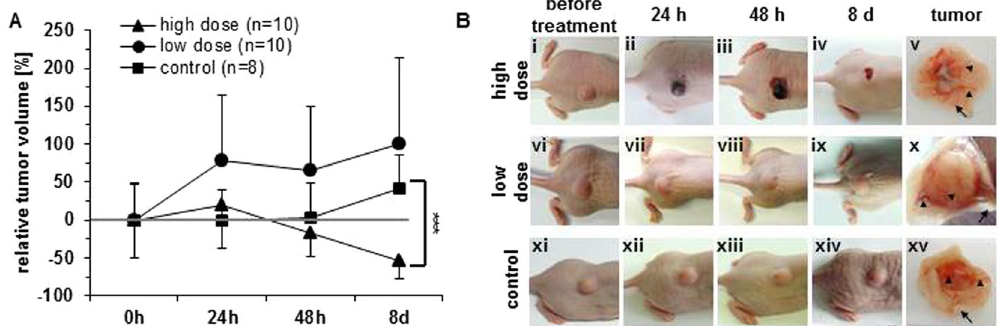
Figure 6. Low dose hyperthermia (42 °C) has no distinct impact on tumor volumes, whereas high dose hyperthermia (46 °C) induces tumor regression. ( A ) Tumor volumes after hyperthermia were normalized to the initial value prior to treatments. Data represented as mean ± SD (n = 8 or 10 mice for each condition). ( B ) Light images of tumor-bearing mice. The last panel on the right side represents dissected tumors with high degree of vascularization upon application of high dose hyperthermia (arrow-heads = tumor vasculature, arrows = skin). Controls were not subjected to any hyperthermia